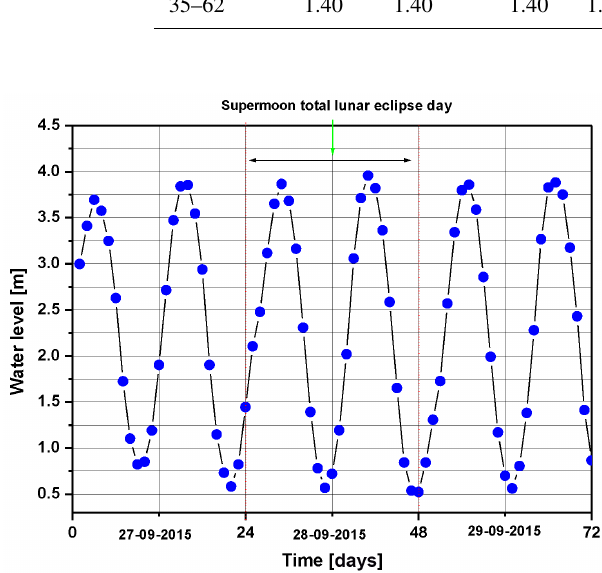
Figure 8. Water level measurements at Kenitra location from 27 to 29 September